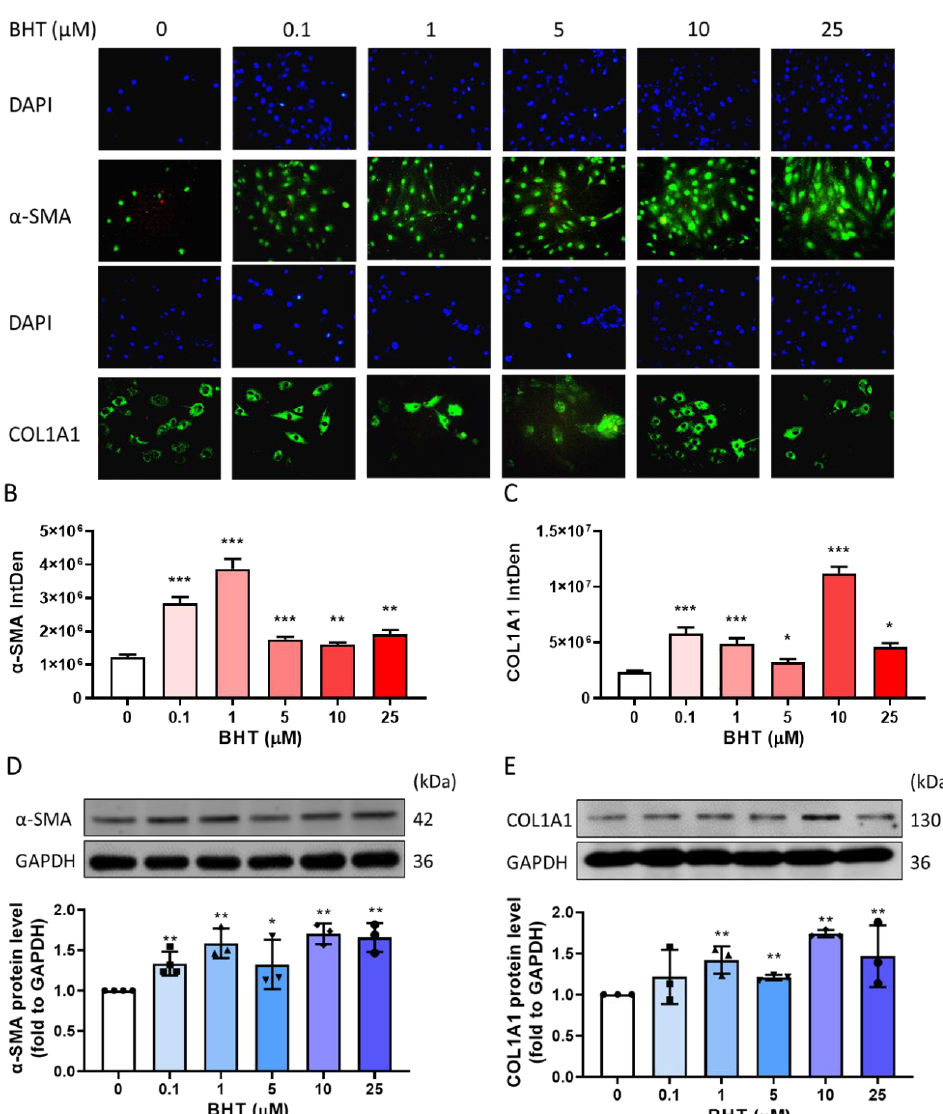
Figure 3. Effect of BHT on extracellular protein expression change. ELT-3 cells were cultured in DMEM/F12 medium. After serum-free starvation for 24 h, cells were treated with different concentrations of BHT for 48 h, and the following experiments were performed: ( A ) immunofluorescence to measure expression changes, employing graphical representations of the fluorescence intensity levels of ( B ) α -SMA and ( C ) COL1A1. Additionally, increased ( D ) α -SMA and ( E ) COL1A1 protein expression ( n = 3–4) are shown. *, p < 0.05; **, p < 0.01; ***, p < 0.001, compared with the control group. We used a fluorescent microscope at 40 × magnification. IntDen: integrated